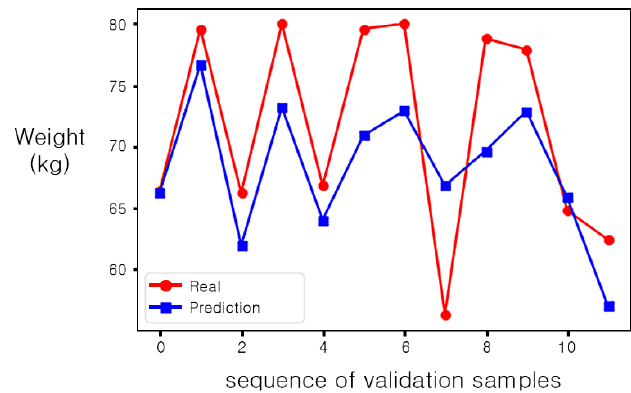
Figure 12. Comparison between the body weights and the predicted values of the proposed model.